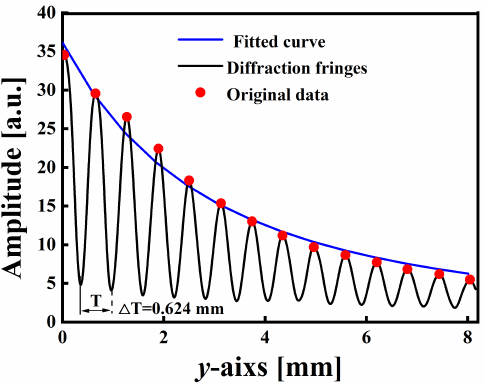
Figure 3. Fitting of extreme value points for the diffraction fringe. The black curve is the diffraction fringe; the red spots are the laser intensity extremums; the blue curve is the extremum fit